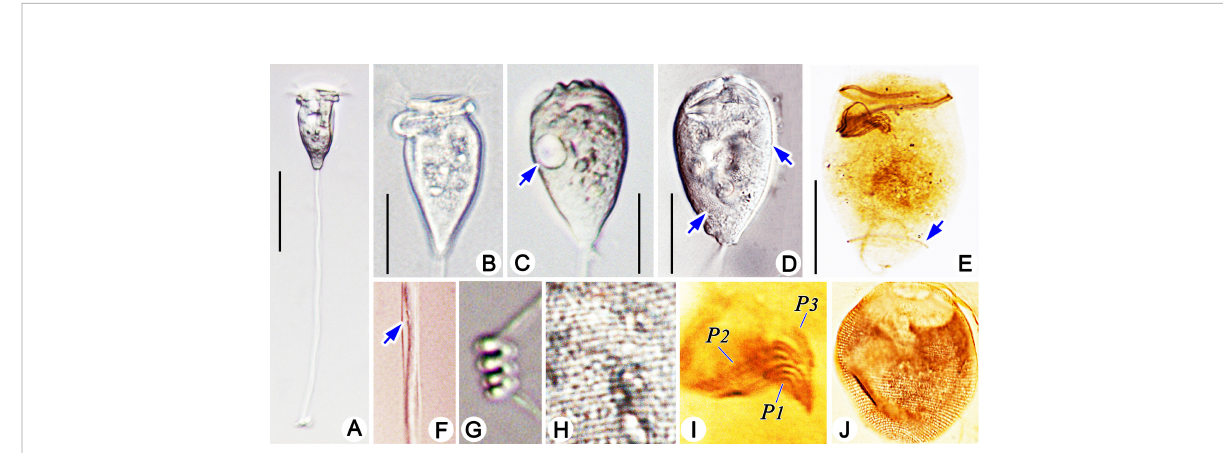
FIGURE 4 Photomicrographs of Pseudovorticella dalianensis sp. n. in vivo (A – D, F – H) , after protargol staining (E, I) and after silver nitrate staining (J) . (A) A typical complete individual. (B) A typical zooid. (C) Arrow marks a contractile vacuole. (D) Arrows point to a macronucleus. (E) Overview of the ciliature; arrow marks the aboral trochal band. (F) Details of the stalk and spasmoneme; arrow indicates granules. (G) Helically contracted stalk. (H) Pellicular striations. (I) Arrangement of infundibular polykineties. (J) Overview of the silverline system. P1 – 3, infundibular polykinety 1 – 3. Scale bars: 60 m m (A) and 30 m m (B – E) .